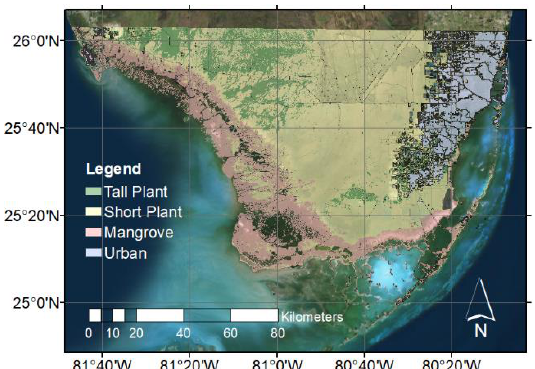
Figure 3. Land covers map of the southern part of the study area, based on four main classes. All the land cover classes are displayed with 40%